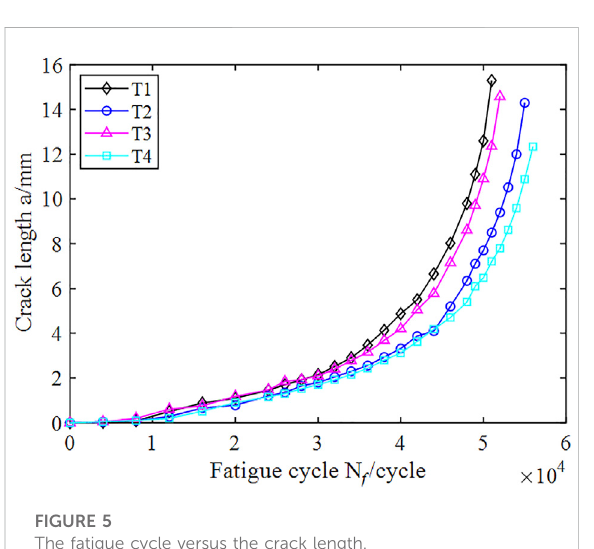
FIGURE 5 The fatigue cycle versus the crack length.